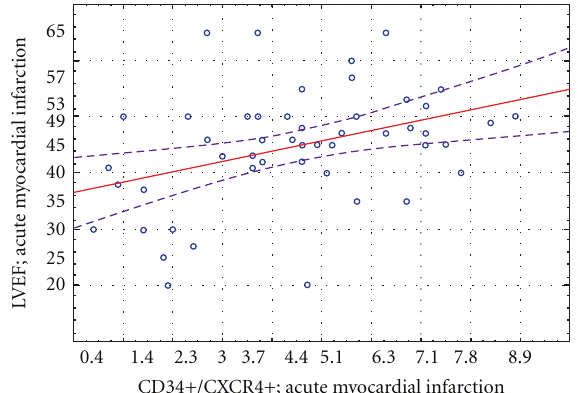
Figure 6: Correlation between CD34+CXCR4+ cells mobilization and initial LVEF value in patients with